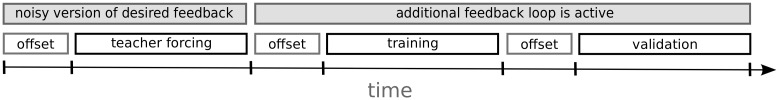
Training and validation of fDCR.Input-output pairs are split into three consecutive phases. In the teacher forcing phase, the feedback readouts are trained. In the training phase, feedforward readouts are trained to solve computational tasks that require both fading and nonfading memory. in the validation phase, the model performance is assessed with unseen data. Each phase is preceded by a brief offset for the fading memory of the fDCR to wash out.